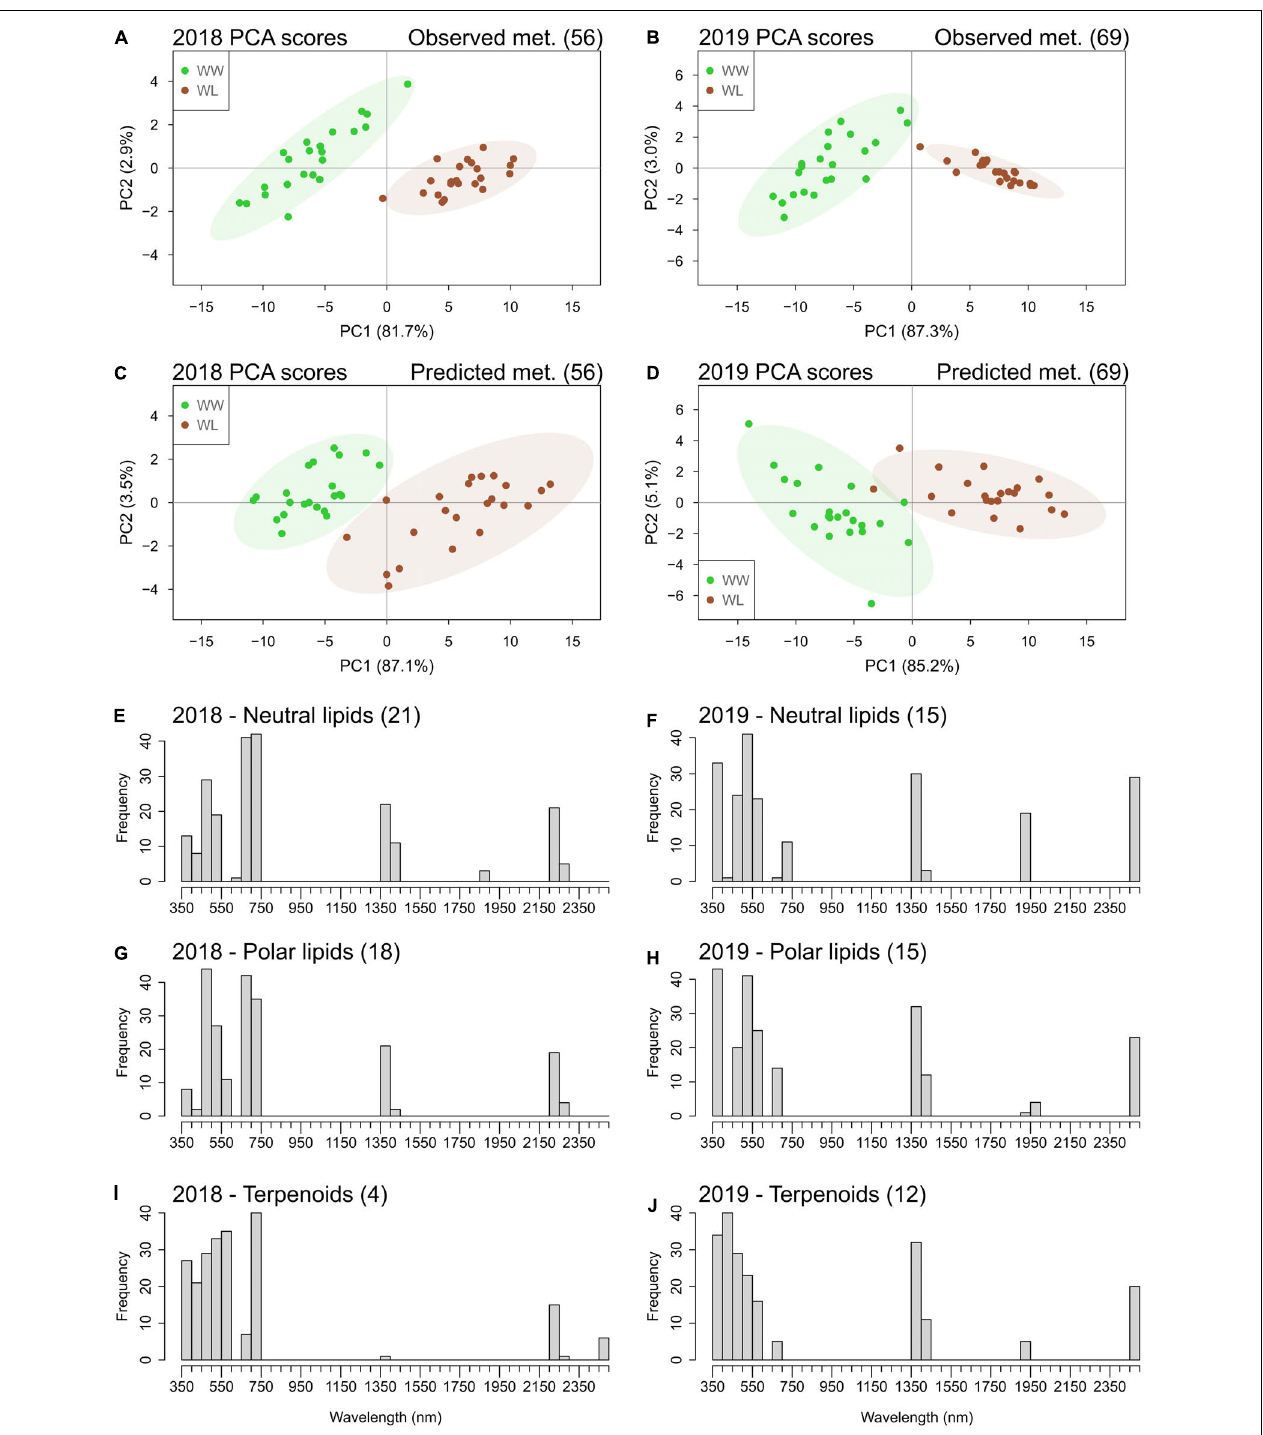
FIGURE 6 | Principal component analysis score plots of leaf samples of the 22 cotton accessions based on observed (A,B) and accurately ( Q 2 > 0.50) predicted (C,D) metabolites (met.) values in 2018 and 2019. The percentage of sample variation explained by the first two principal components (PC1 and PC2) is reported in brackets. Well-watered (WW) leaf samples are in green; water-limited leaf samples are in brown. Ellipses represent the 95% confidence level for the samples of each treatment. Histograms of the frequencies of the top 10% wavelengths selected by the hyperspectral-based models for quantifying metabolites belonging to the classes of neutral lipids (E,F) , polar lipids (G,H) , and terpenoids (I,J) in the 2 years. The number of metabolites in each class is indicated in brackets next to the class name (a full list of these metabolites and the regression coefficients of the wavelengths of their specific models is reported in Supplementary Tables 11, 12 ).